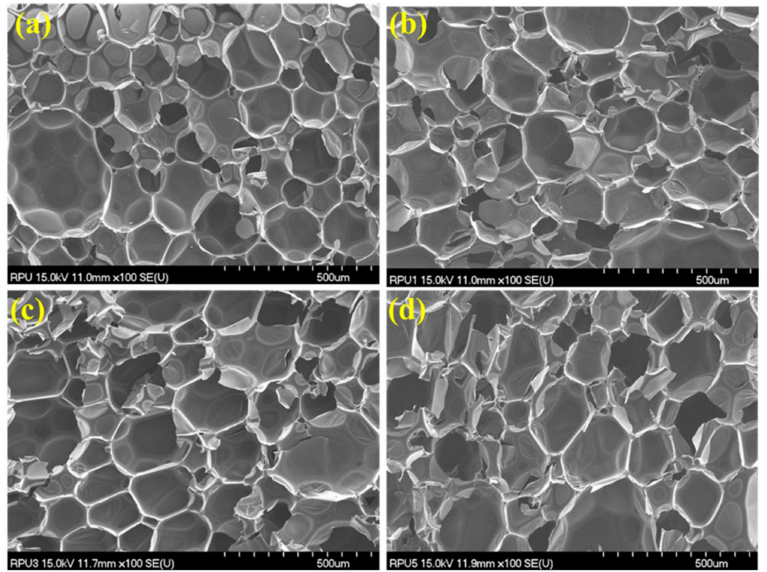
Figure 1. SEM images of the neat RPU and flame retardant RPU foam samples: ( a ) neat RPU, ( b ) RPU/IFR0, ( c ) RPU/IFR1, and ( d )